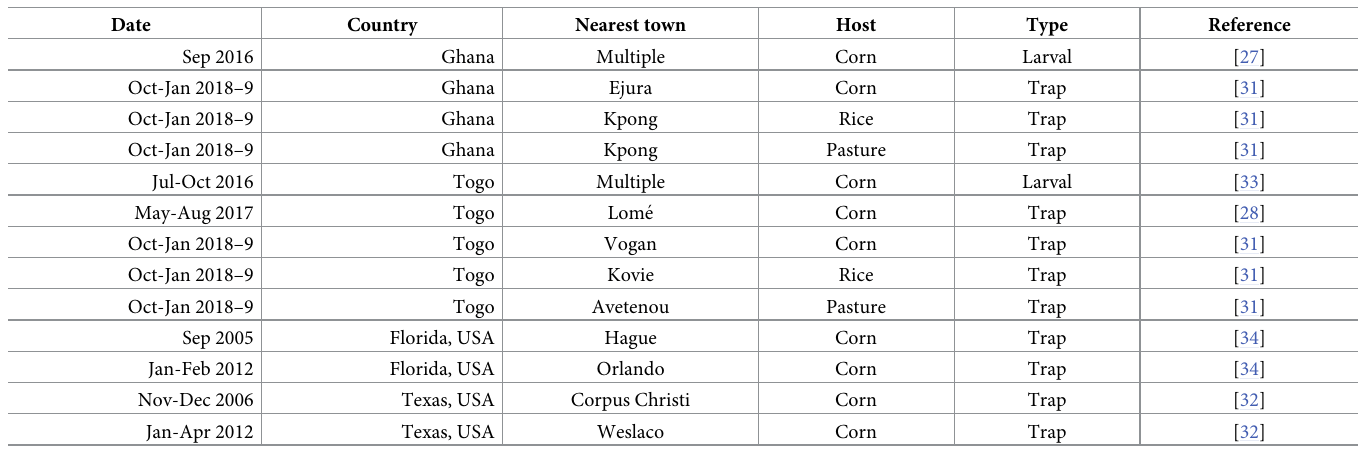
Table 1. Information for fall armyworm